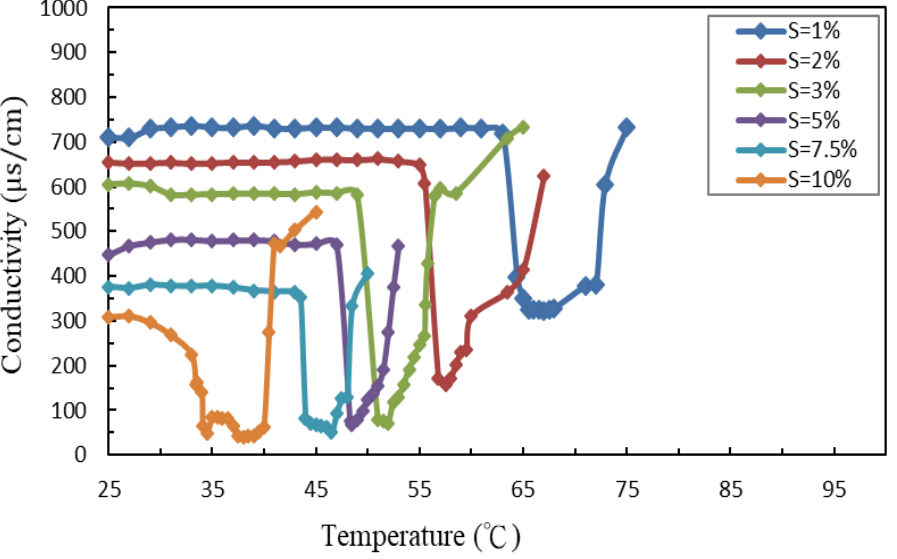
Figure 3. Effects of heating temperature and surfactant Brij 30 concentrations on the electrical conductance of emulsions.